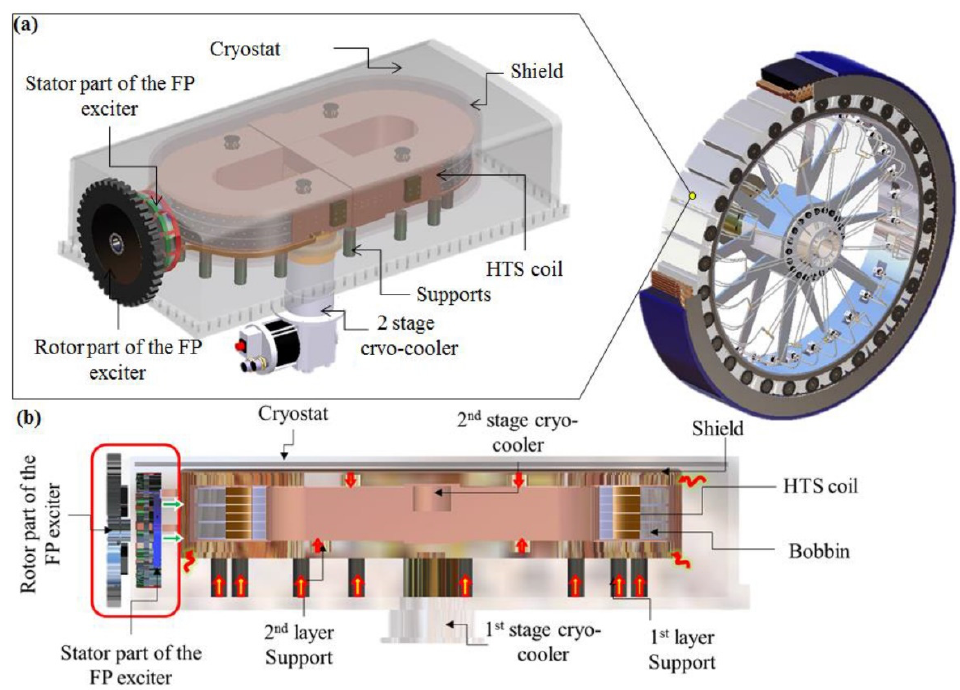
Figure 17. Configuration of the rotary HTS flux pump-based module coil. ( a ) overview ( b ) cross section view, of a separated unit of HTS field coils. Reprinted from [139].